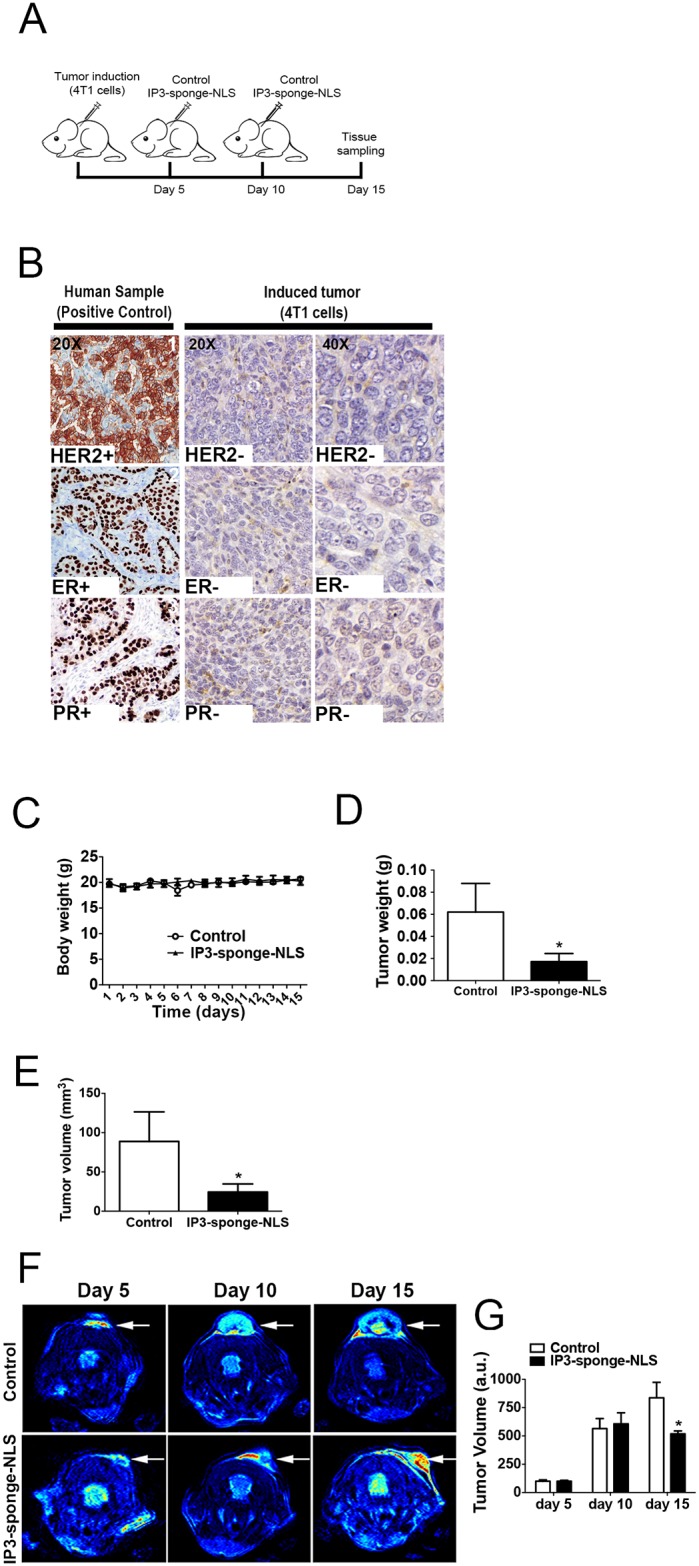
Nuclear IP3 buffering impairs TNBC growth in vivo.(A) In vivo experimental design. (B) Representative photomicrographs of human invasive breast carcinomas positive for HER2 (1), ER (2) and PR (3) that were used as external control in our immunohistochemical study (left panels) (20x magnification). Right panels show that 4T1-induced tumor has no staining for any of the markers used (20x and 40x magnification). (C) Daily weight along the experiment (n = 5 animals). (D) Tumor weight at day 15, after 2 sequential treatments with either the IP3-sponge-NLS construct or vehicle solution (n = 5). (E) Tumor volume at day 15, after the 2 sequential treatments (n = 5 animals). (F) Representative images of tumors magnetic resonance imaging, at days 5, 10 and 15 after tumor induction. White arrows indicate tumor location. (G) Quantification of MRI tumor volume at indicated days after tumor induction (n = 5 animals). * = p <0.05 versus control. Values are expressed as mean ± SD.